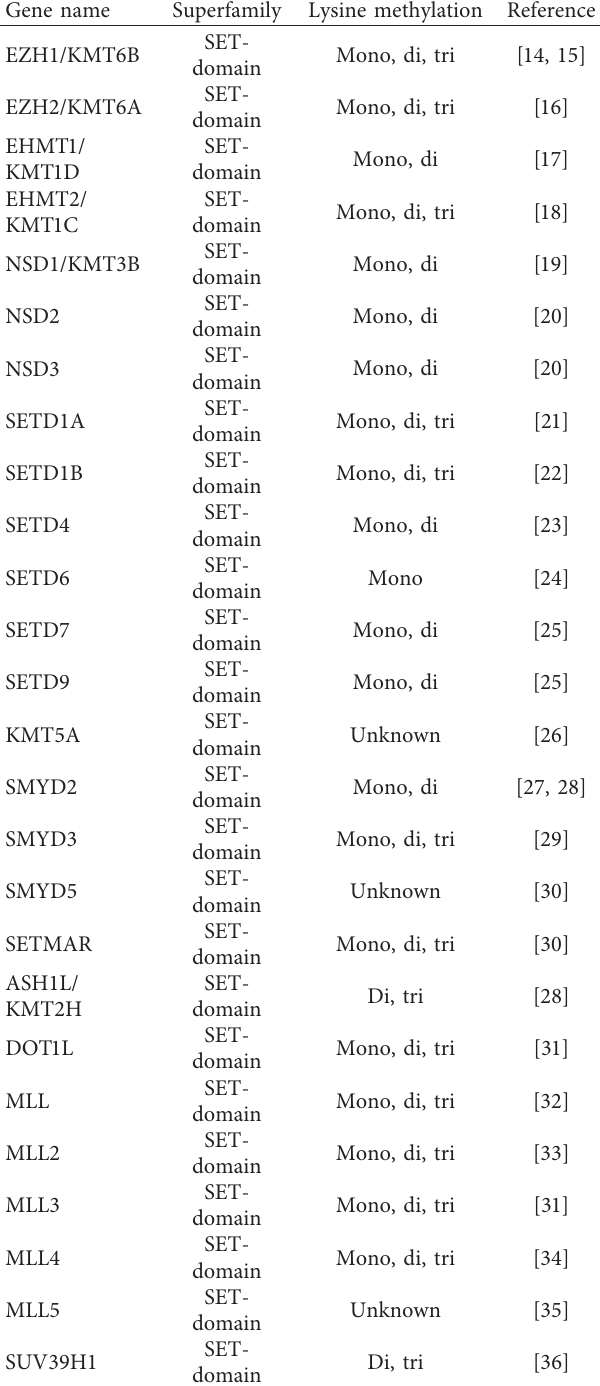
Table 1: Enzymes with lysine-methylating activity. The enzymes in the SET-domain family and the 7 β -strand family that are active in lysine methylation. Also listed are the known methylation states each enzyme is capable of producing. Many lysine-methylating enzymes have disputed function, and the 7 β -strand family is still being investigated in eukaryotes.